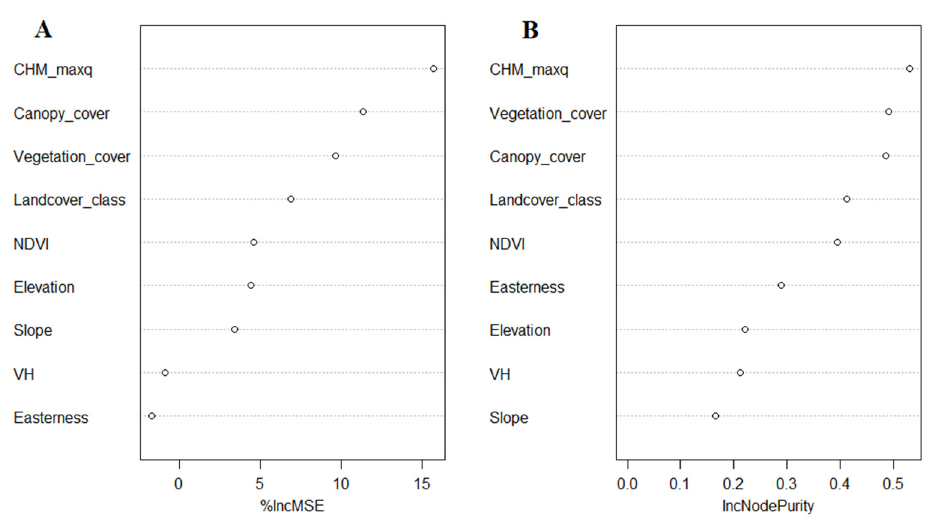
Figure 5. Variable importance of the Random Forest model for 1-h fuel load estimation measured by ( A ) the percentage increase in Mean Squared Error (%IncMSE) and ( B ) increase in node purity (IncNodePurity). Abbreviations are: Easternness = Easterness of each plot, VH = VH polarization, Slope = Slope in each plot, Elevation = Elevation of each plot, NDVI = Normalized Difference Vegetation Index, Landcover_class = Land-cover class in each plot, Vegetation_cover = Vegetation cover, Canopy_cover = Canopy cover, and CHM_maxq = Canopy Height Model 95th percentile.